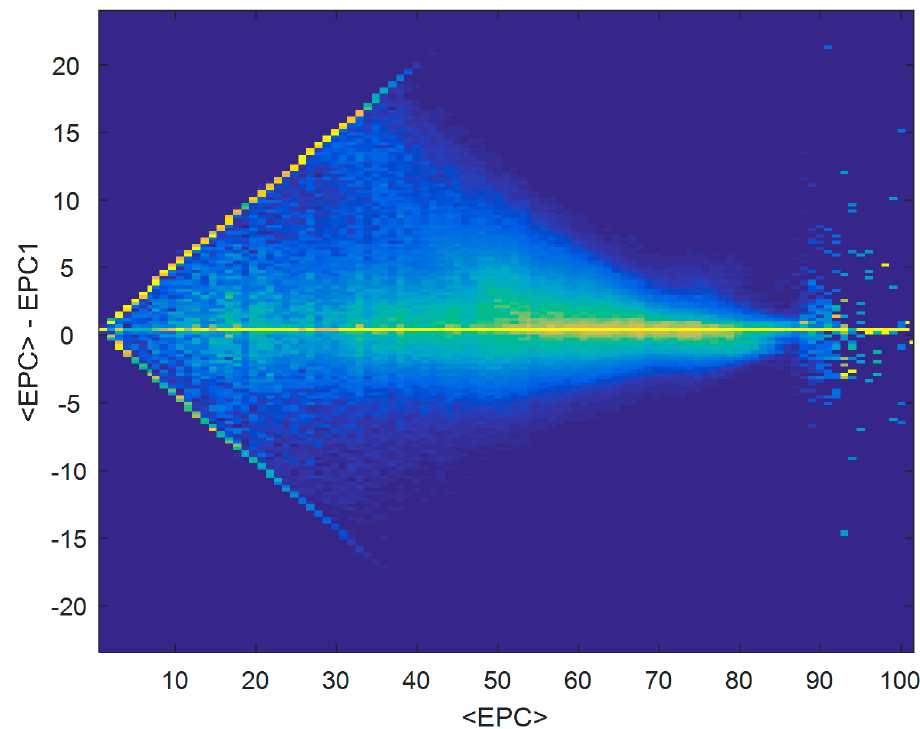
Figure 6. Normalised version of Figure 6, allowing the spread at every value of < EPC > to be observed. No colour bar is given, as in this plot a given colour does not map onto the same number of dwellings at all values on the x -axis.